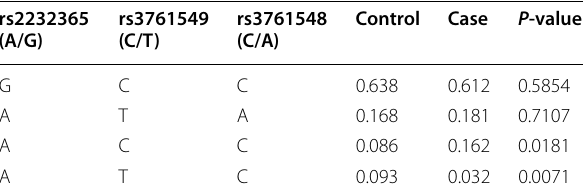
Table 4 Distribution of the foxp3 haplotypes in schizophrenia patients and healthy